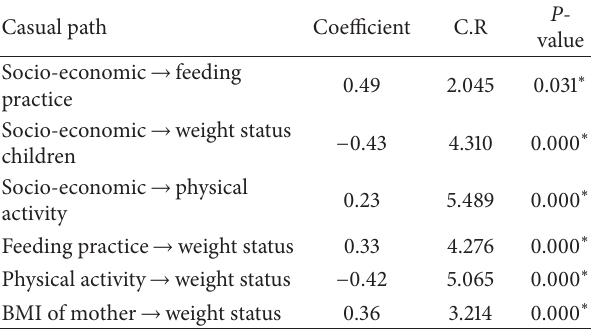
Table 7: Confirmatory factor analysis for testing structural model fit.